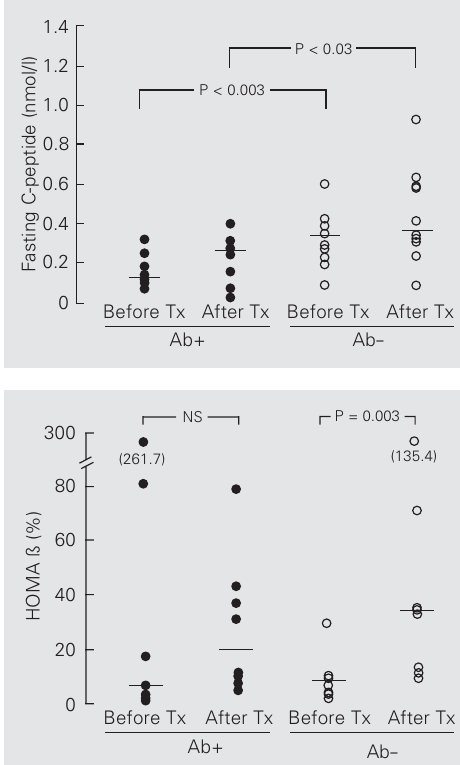
Figure 2. Comparison of homeo- stasis model assessment ß (HOMA ß) between autoanti- body-positive (Ab+) and autoan- tibody-negative (Ab-) diabetic patients with oral hypoglycemic agent failure, before and after insulin treatment (Tx). The sta- tistical tests used were Mann- Whitney rank-sum test and Wil- coxon signed rank test. NS = nonsignificant.